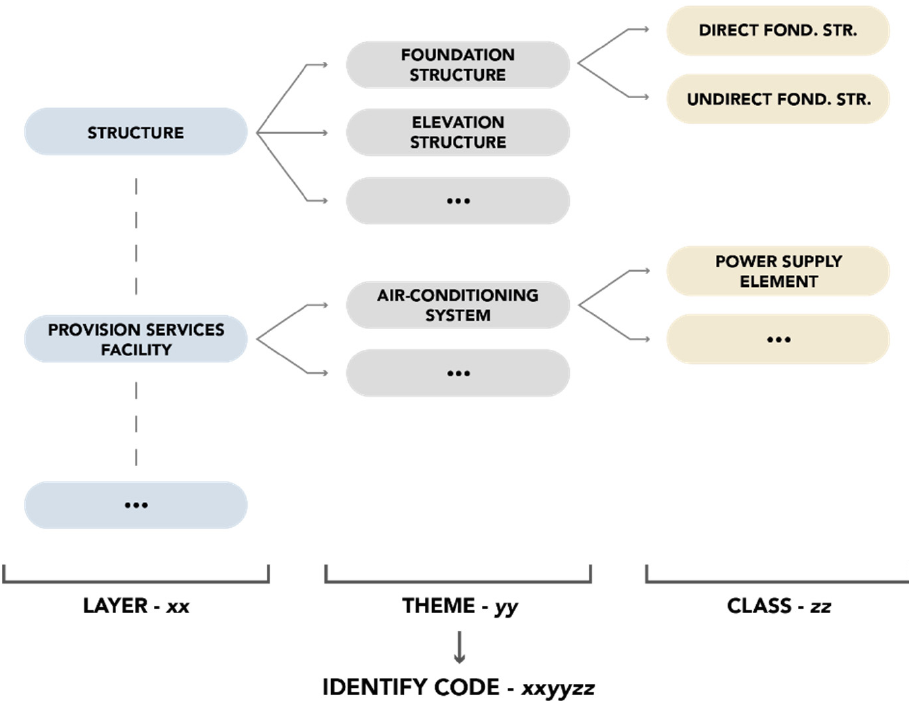
Figure 5. Structure of the classification and nomenclature scheme use for the CISISI Geotopographic Database.